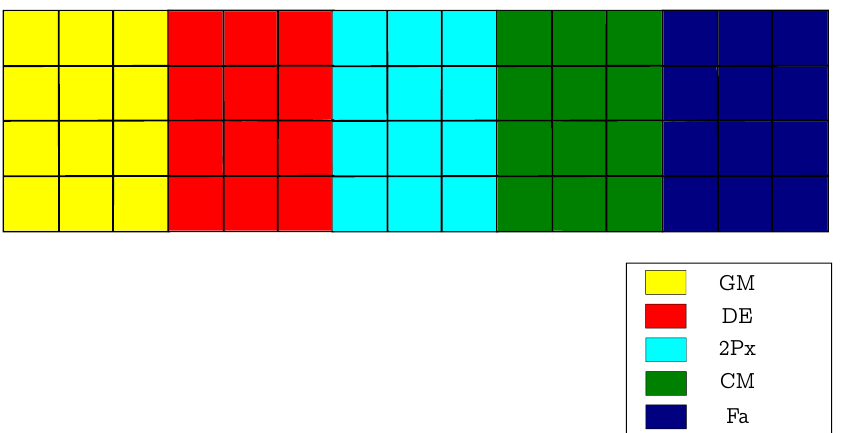
Figure 1. Reef in the CRO-SL example. An example where 5 different substrates stand for different search procedures: Gaussian mutation (GM), differential evolution (DE), two-point crossover (2Px), Cauchy mutation (CM), and the firefly algorithm